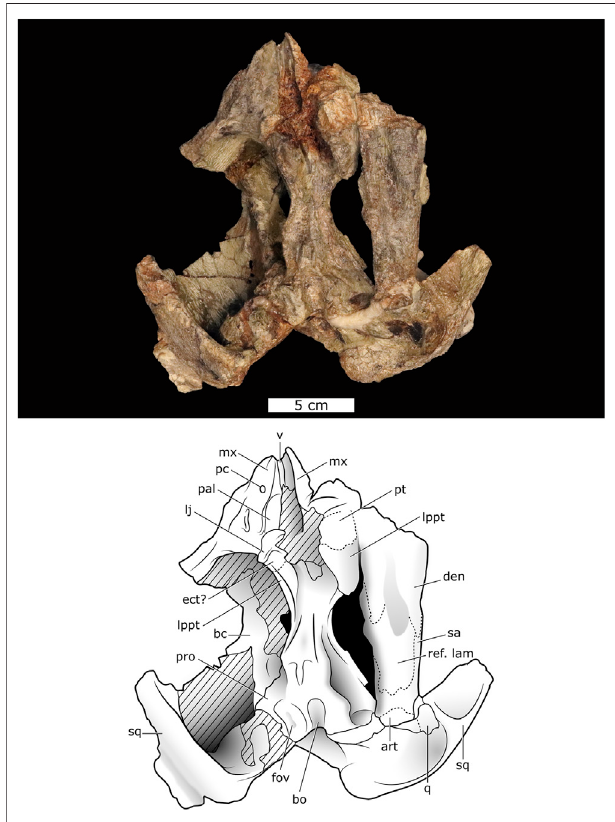
FIGURE 3 | Ventral view of Lanthanostegus specimen